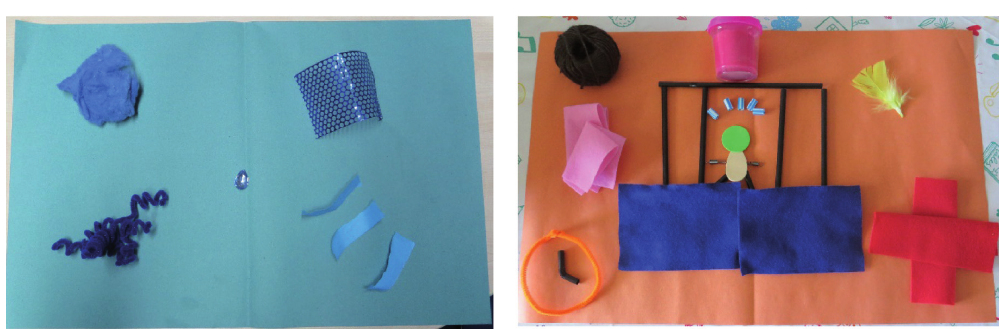
Figure 2: Examples of collage (left: Veronica; right: Kathryn)